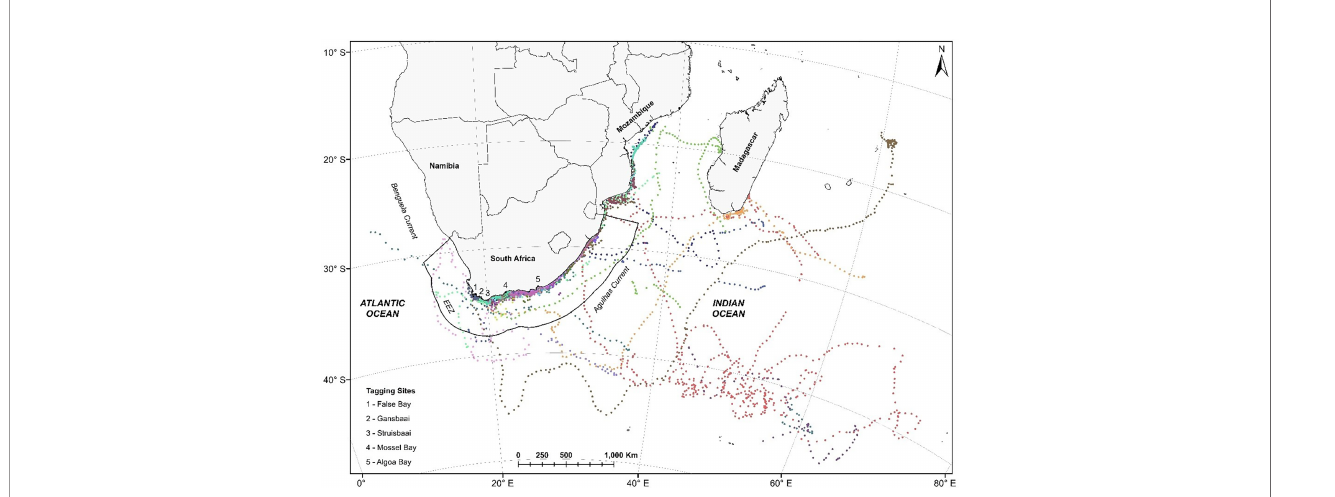
FIGURE 1 | Satellite tracks of 33 white sharks Carcharodon carcharias tagged at fi ve locations along the South African coast in 2012. Each colour represents an individual shark ’ s track between 2012 and 2014. These are time-regular predicted locations (one location every 12 hours) from a correlated random walk model fi tted to the original data, accounting for the estimated CLS Argos location error, using the foieGras package in R (Jonsen and Patterson,